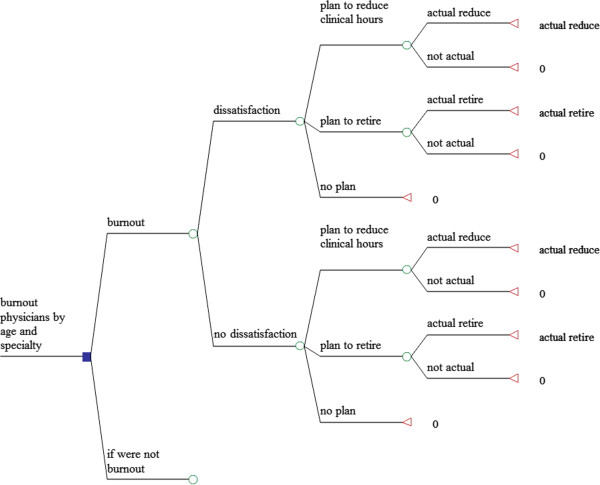
Model structure.